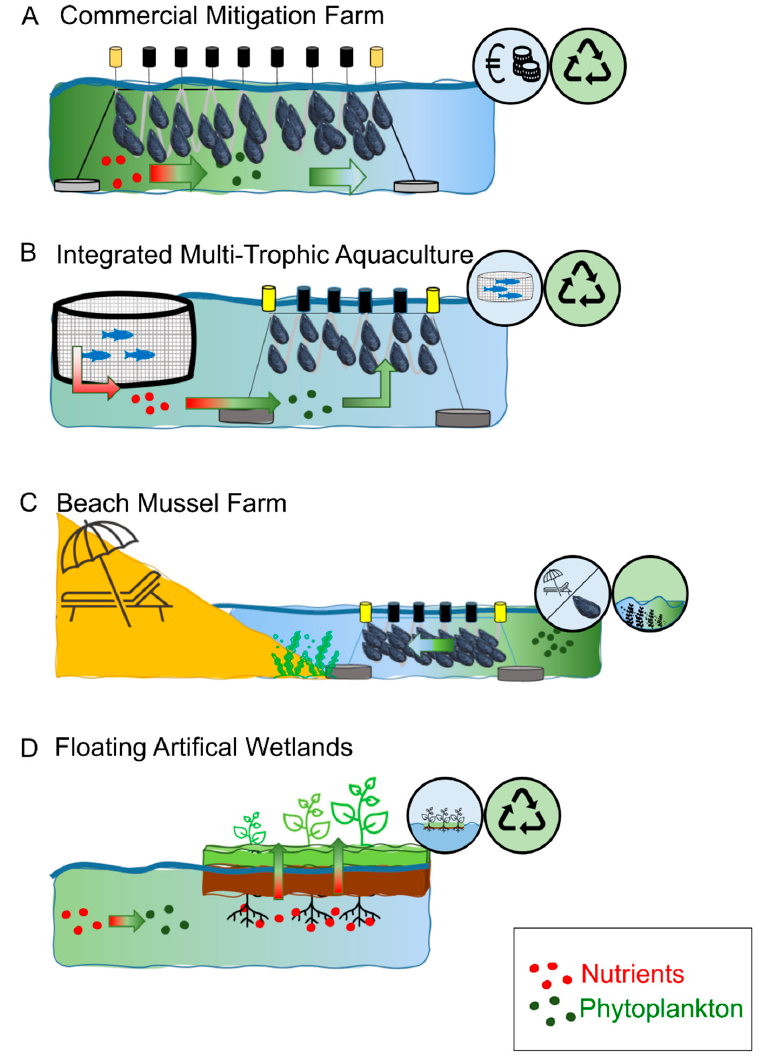
Figure 2. Different ecological measures consisting of different mussel farm strategies ( A – C ) and the example of an artificial floating wetland ( D ) (not to scale).